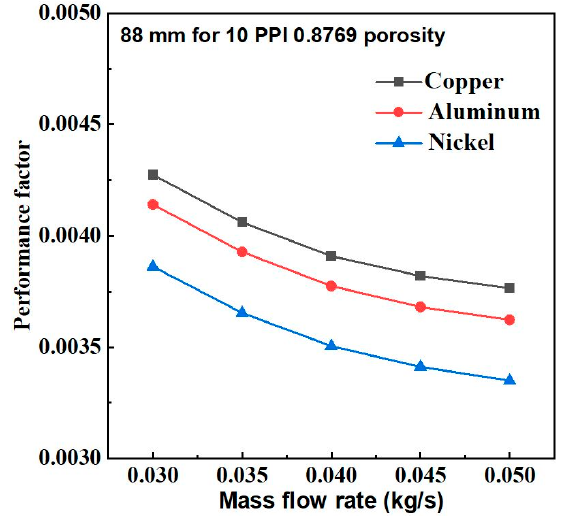
Figure 16. Variation of performance factors for different mass flow rates for different material .